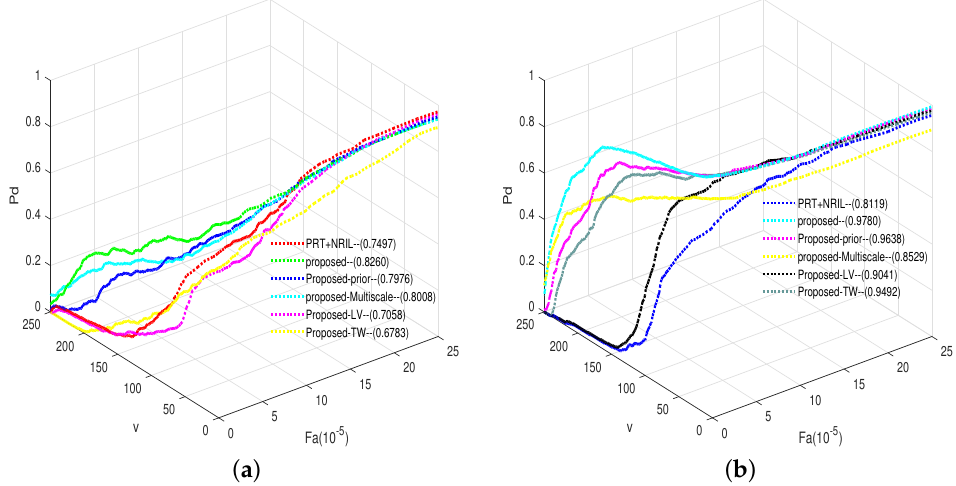
Figure 14. 3-D curves of ablation experiments, showing detection probability versus the false alarm rate and the parameter vs. in Equation (22). In the legends, the corresponding AUCS are shown. The “-” in the legend is the experiment performed by removing a certain part of the proposed algorithm. ( a , b ) are experimental results obtained in data 1 and data 2, respectively.